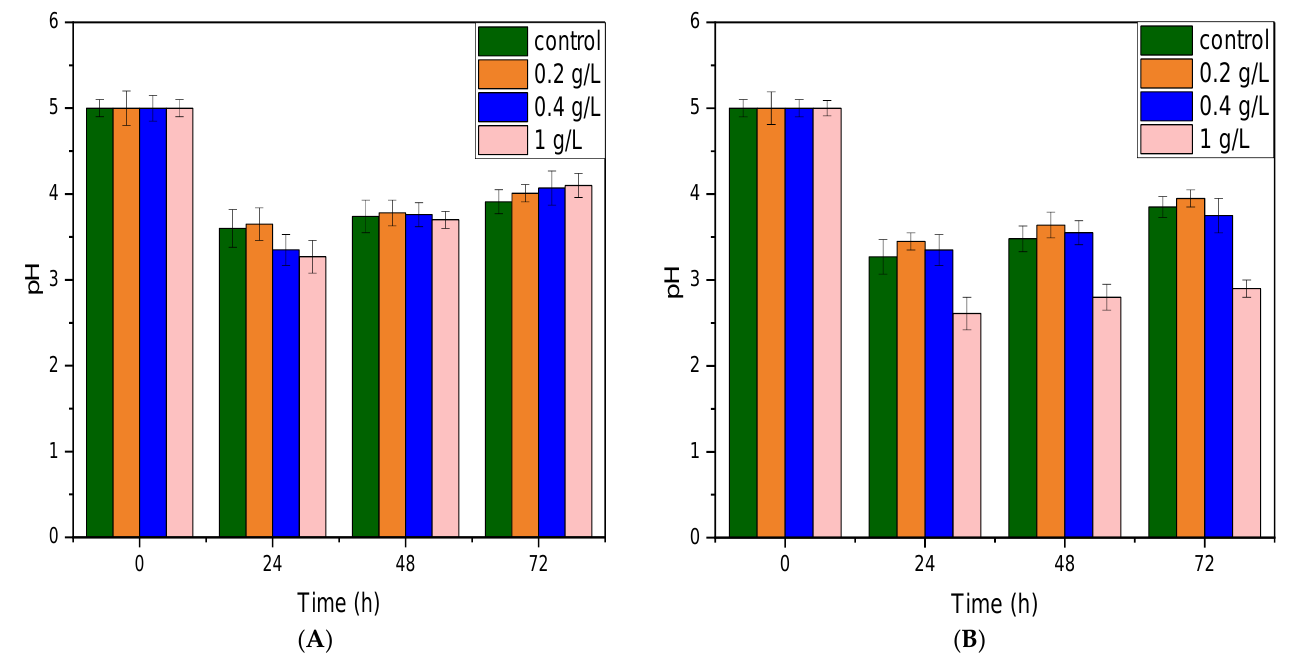
Figure 6. pH evolution during anaerobic fermentation: ( A ) effect of yeast extract and ( B ) effect of NH 4 Cl.